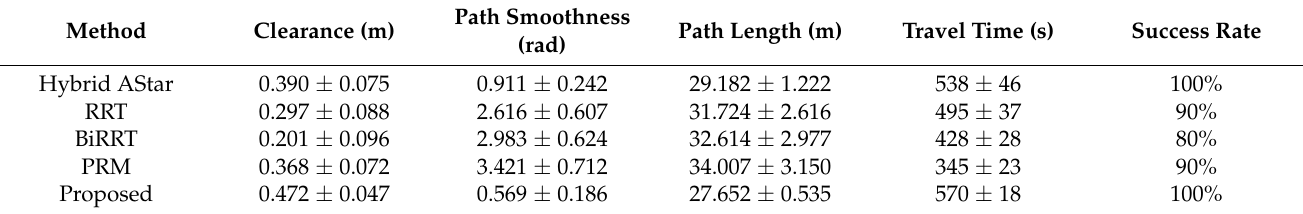
Table 2. Quantitative results for the second